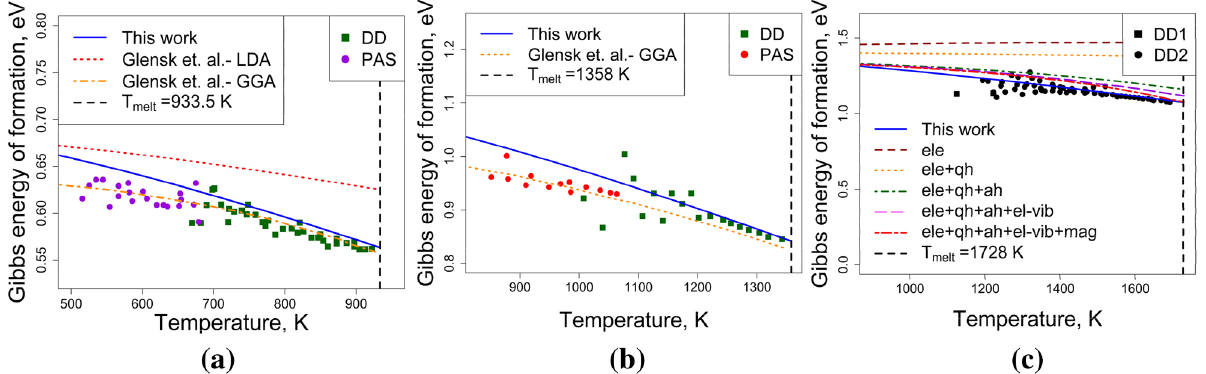
Figure 8. Gibbs energy of vacancy formation for ( a ) FCC-Al, ( b ) FCC-Cu, and ( c ) FCC-Ni, comparing the model performance against experimental data [PAS: positron annihilation spectroscopy 36 , DD: differential dilatometry 36,54–58 ] and atomistic simulations 38 .